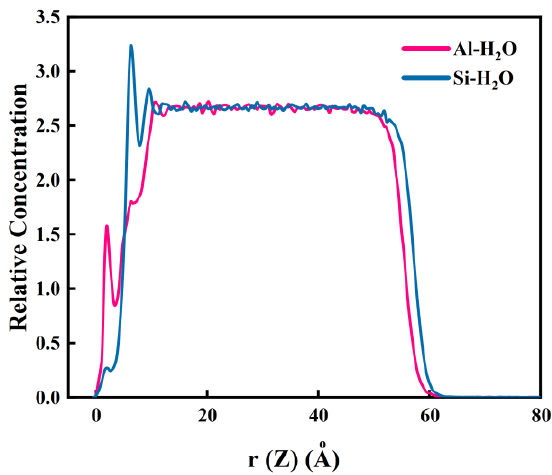
Figure 14. Relative concentration distributions of water molecules on kaolinite 001 surface and Kaolinite 00 1̅ surface. Kaolinite 001 surface.